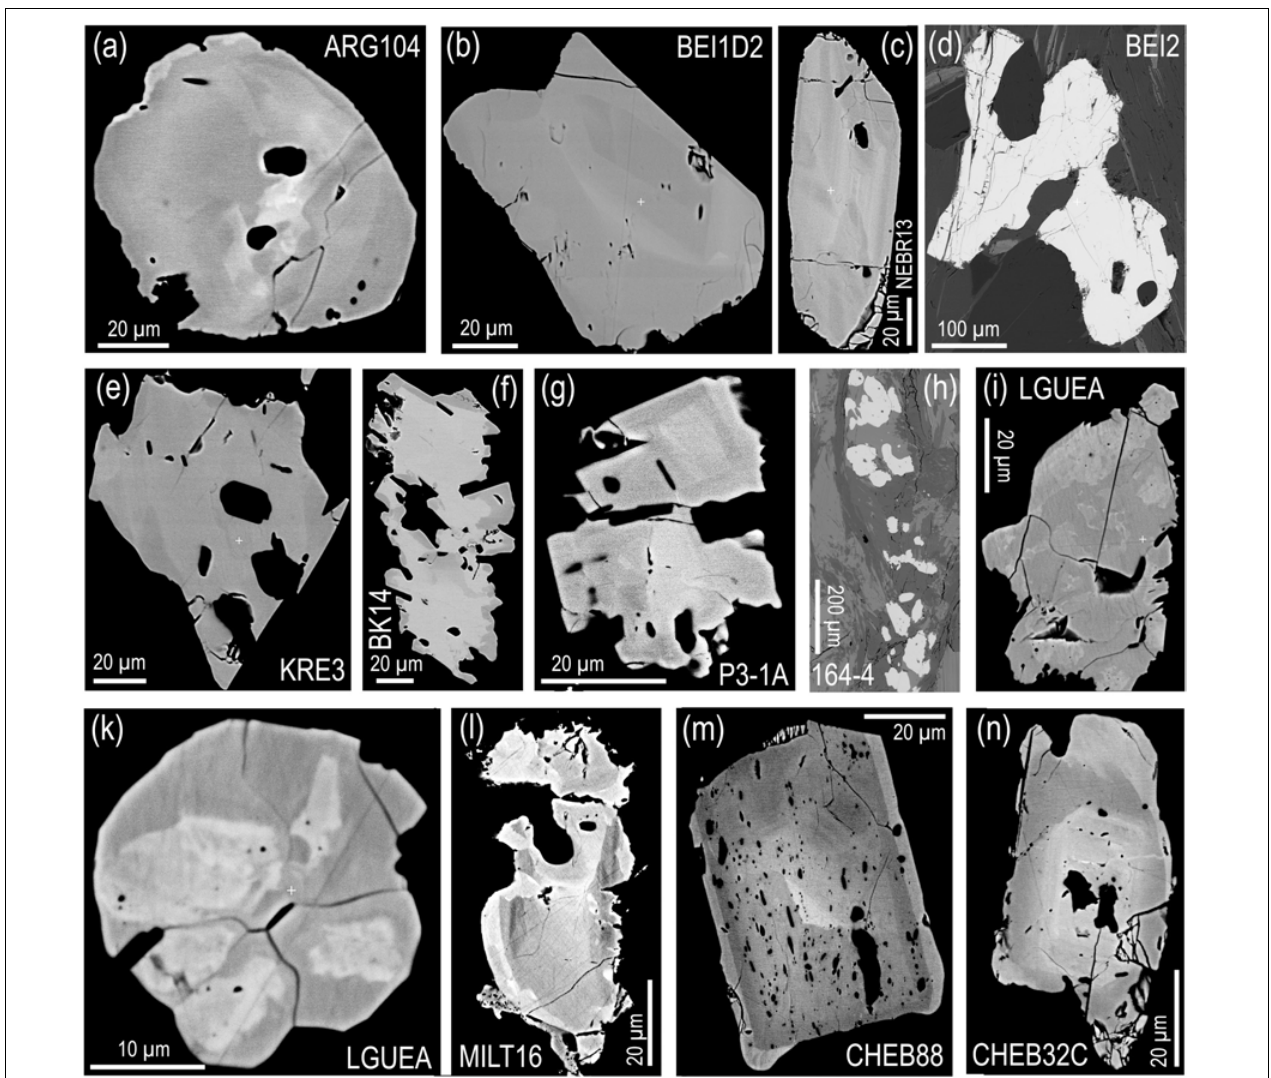
FIGURE 4 | Monazite in amphibolite facies micaschist. (a) Euhedral monazite with rounded corners and cloudy Th-rich core zone, Conlara, Argentina (Lopez de Luchi et al., 2020). (b) Euhedral and nearly homogeneous monazite with rounded corners in a micaschist from the Cretaceous high-pressure Eclogite Unit of the Saualpe (Schulz, 2017). (c) Long prismatic monazite from the Carboniferous amphibolite-facies Austroalpine Oetztal-Stubai Basement, Eastern Alps (Rode et al., 2012). (d) Amoeboid grain shape of monazite (Saualpe). (e) Irregular grain shape of monazite (Saualpe). (f) Highly irregular grain shape of monazite in a micaschist (Central Erzgebirge). (g) Highly irregular grain shape of monazite with rectangular and sutured grain boundaries, from “Schiefererz” micaschist, Pöhla, Western Erzgebirge. (h) Arrangement of numerous large monazite grains in a quartz-rich layer of garnet micaschist of Moldanubian diaphthorite zone (NE Bavaria). (i,j) Contact metamorphic monazite in enclaves of garnet hornfels in the granite of Rostrenen, Central Brittany (Schulz, 2013). (l) Monazite in an andalusite micaschist from Miltitz in the Nossen-Wilsdruff Schiefergebirge, Saxothuringian Zone. (m,n) Euhedral monazite with zonation and helicitic inclusions in cordierite micaschist from the Waldsassen Schiefergebirge in the Saxothuringian